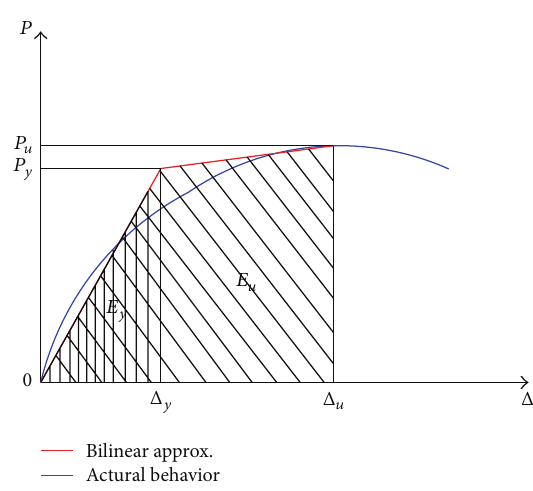
Figure 10: The idealised load-midspan deflection curve.